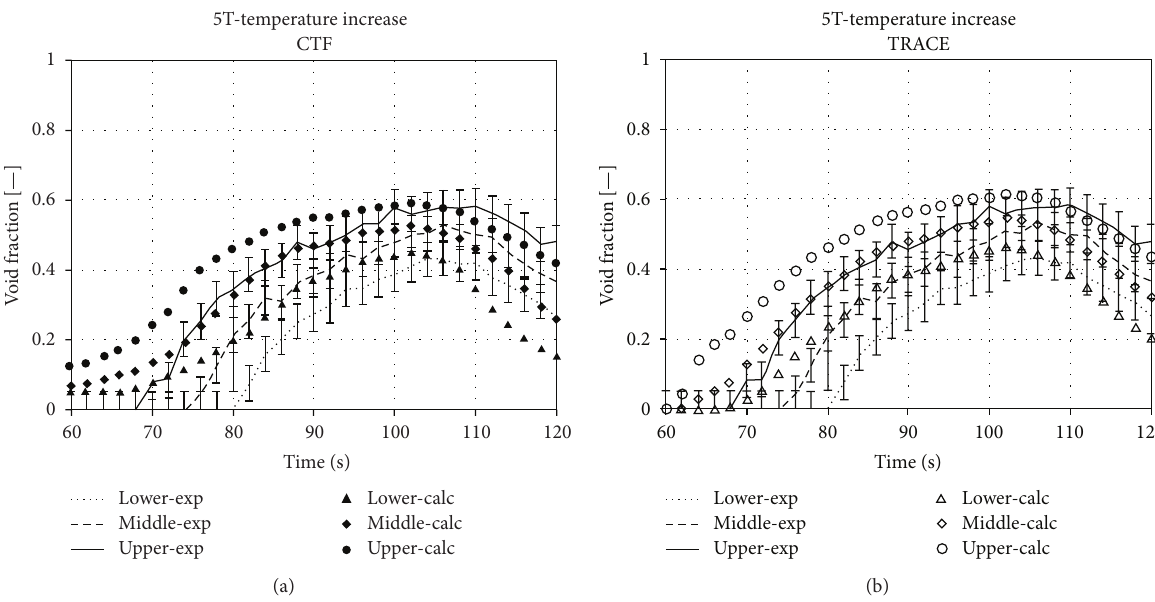
Figure 5: CTF (a) and TRACE (b) predictions of void fraction in bundle type B5 during flow depressurization transient.